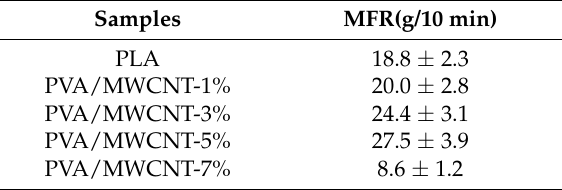
Table 2. Melt flow rate (MFR) properties of PLA and the PVA/MWCNTs composite